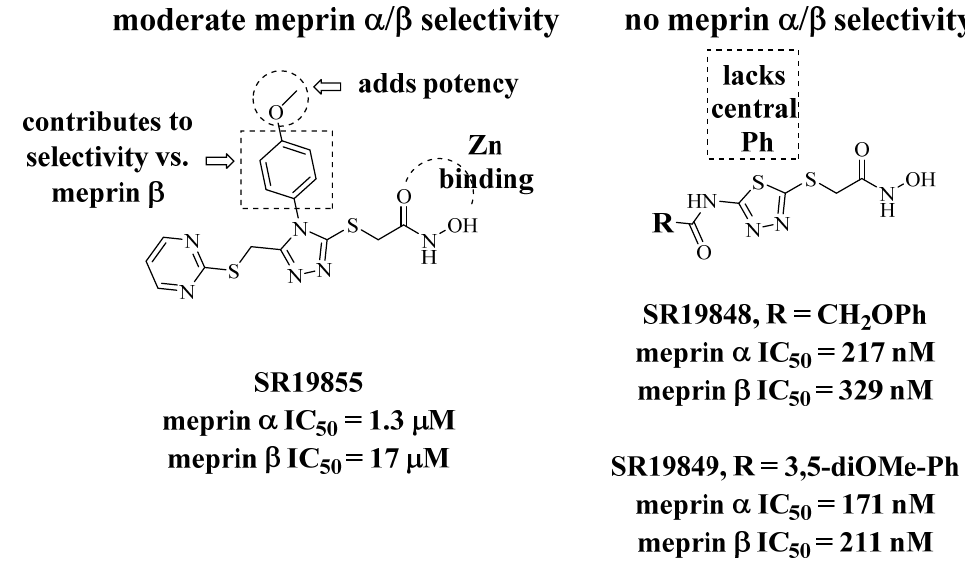
Figure 1. HTS hit, the aryl triazole SR19855 (left), and related, less selective thiadiazoles.